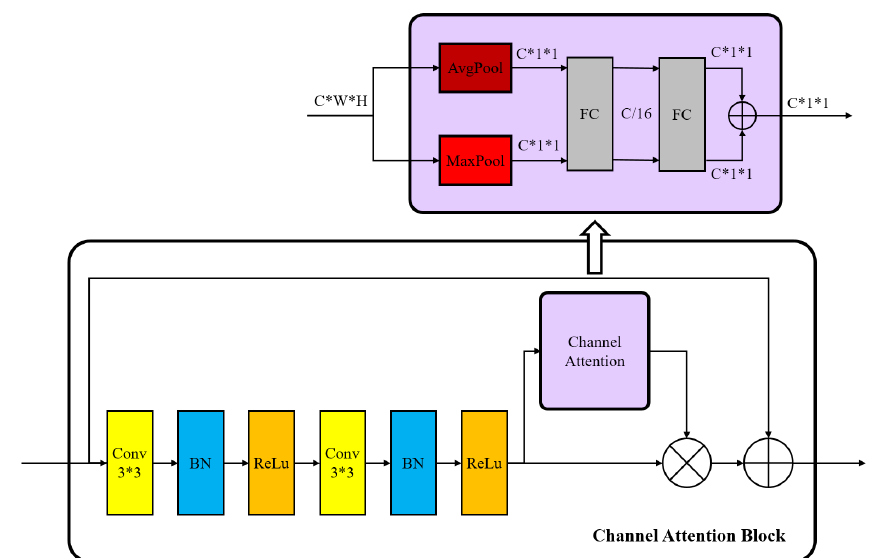
Figure 5. Channel Attention Block. Conv: Convolutional Layer; BN: Batch Normalization Layer; ReLu: ReLU Activation Layer; AvgPool: Average Pooling Layer; MaxPool: Maximum Pooling Layer; FC: Fully Connected Layer.